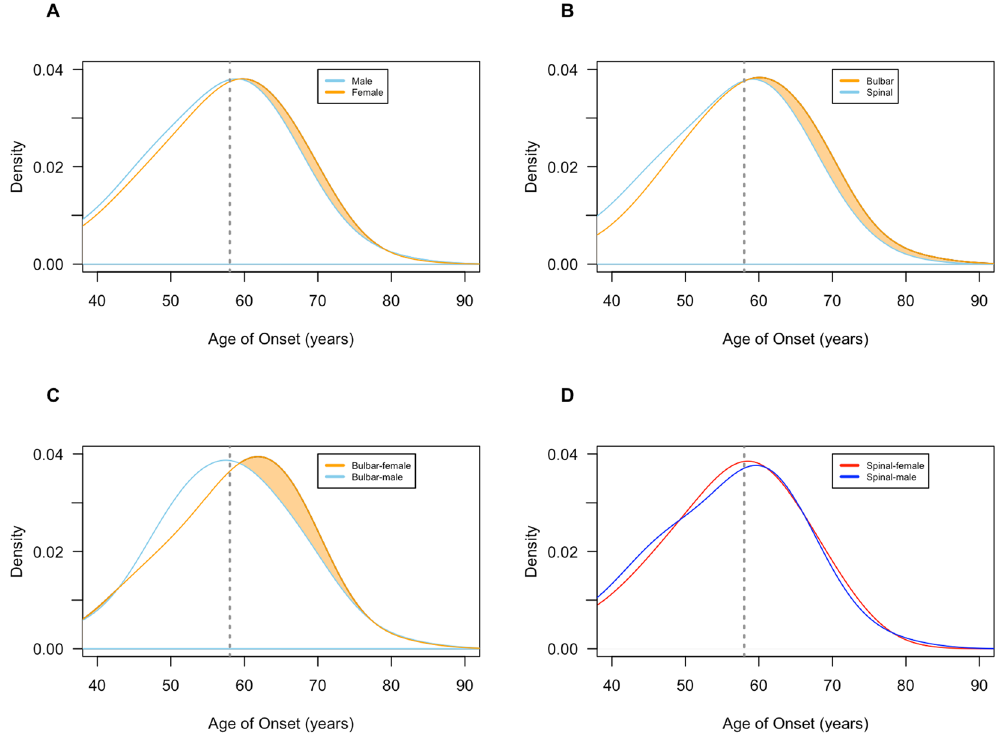
Figure 4. Density plots of age of onset among pathogenic C9orf72 repeat expansion carriers. Density plot showing age of onset frequency distribution ( A ) among male (n = 393) and female (n = 357) ALS cases; ( B ) bulbar-onset (n = 256) and spinal-onset ALS cases (n = 481); ( C ) bulbar-onset male (n = 111) and bulbar-onset female (n = 111) ALS cases; ( D ) spinal-onset male (n = 273) and spinal-onset female (n = 208) cases. Shaded area represents differences between compared subgroups, and the dotted vertical line indicates median age of onset in the overall cohort (58.0 years of